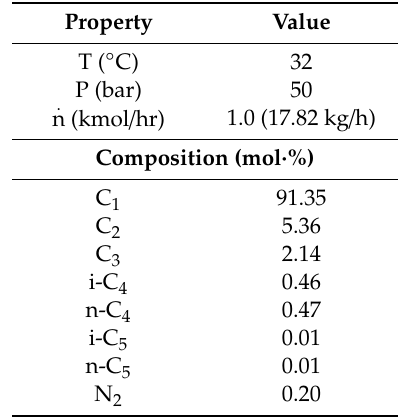
Table 1. Feed NG